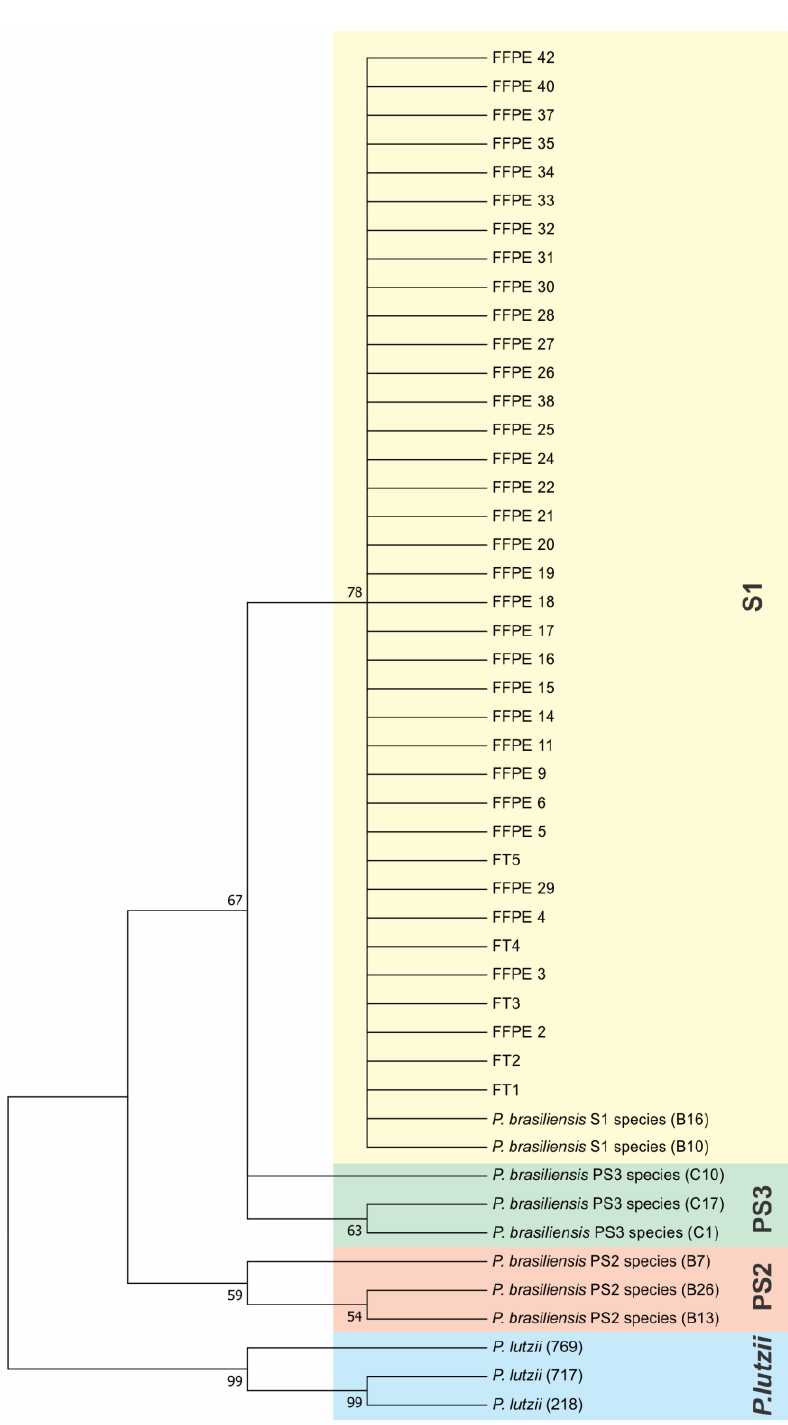
Figure 3. Concatenated ARF and CHS2 genes’ phylogenetic tree using the Maximum Likelihood method based on the Tamura–Nei model. The tree with the highest log likelihood ( − 1354.77) is shown. The percentage of trees in which the associated taxa are clustered together is shown next to the branches. Initial tree(s) for the heuristic search were obtained automatically by applying Neighbor-Join and BioNJ algorithms to a matrix of pairwise distances estimated using the Maximum Composite Likelihood (MCL) approach, and then selecting the topology with superior log likelihood value. The tree is drawn to scale, with branch lengths measured in the number of substitutions per site. The analysis involved 48 nucleotide sequences. All positions containing gaps and missing data were eliminated. There were a total of 776 positions in the final dataset. Evolutionary analyses were conducted in